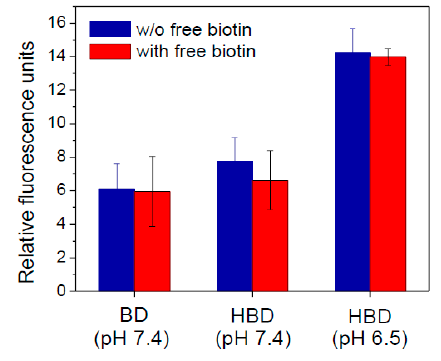
Figure 9. Cell uptake and competition test for BD5 and HBD5 nanoparticles in 4T1 cells.